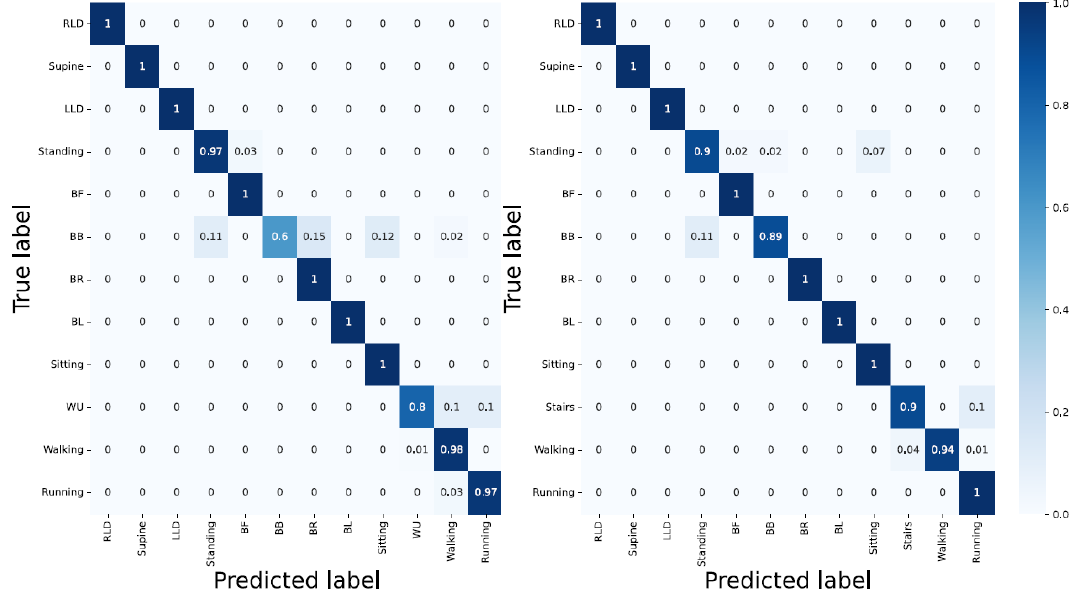
Figure 11. LSTM architecture with left and right, without and with PCA applied and data fusion. LSTM shows a promising performance in bending-related activities.